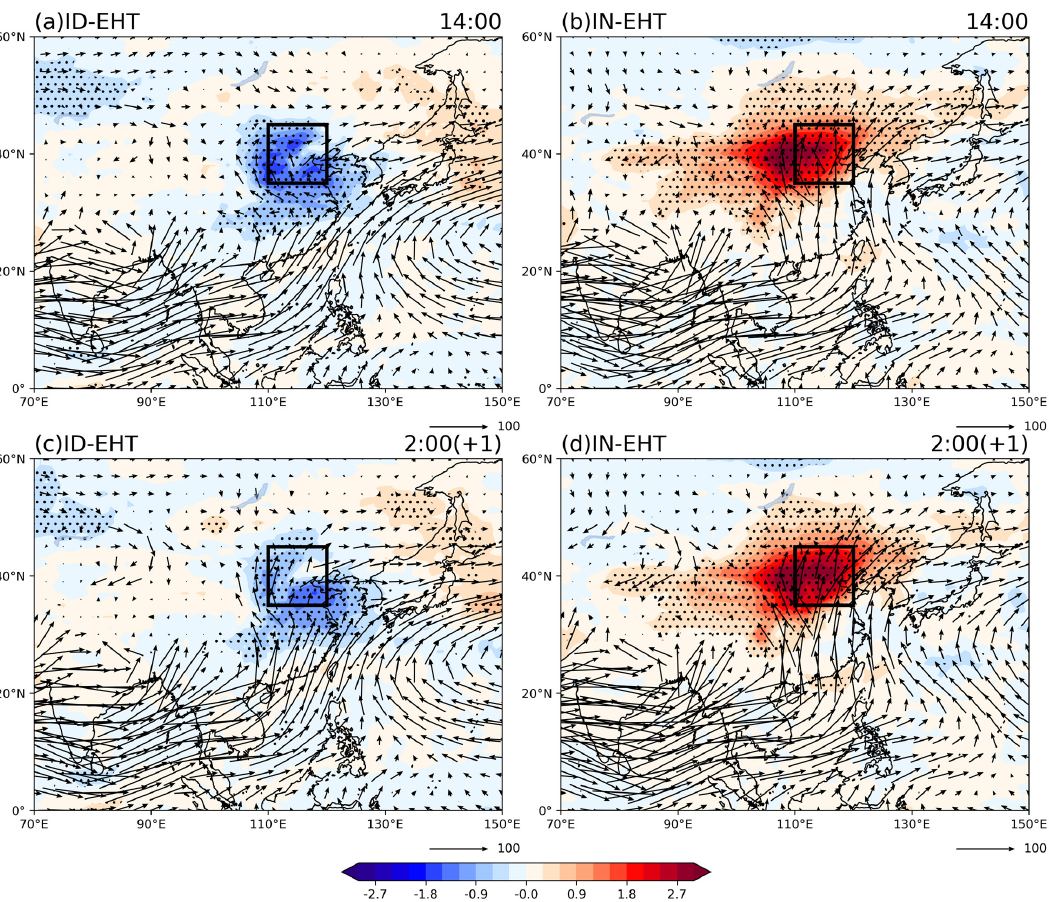
Figure 4. Composite anomalies of 850 hPa specific humidity (shading; unit: g/kg) and water vapor flux (arrows; unit: (m·g)/(s·kg)) at 14:00 ( a ) and at 2:00 of the next day ( c ) for ID-EHT; ( b , d ) are same as ( a , c ) but for IN-EHT. Black dots indicate the anomalies significant at the 95% confidence level.